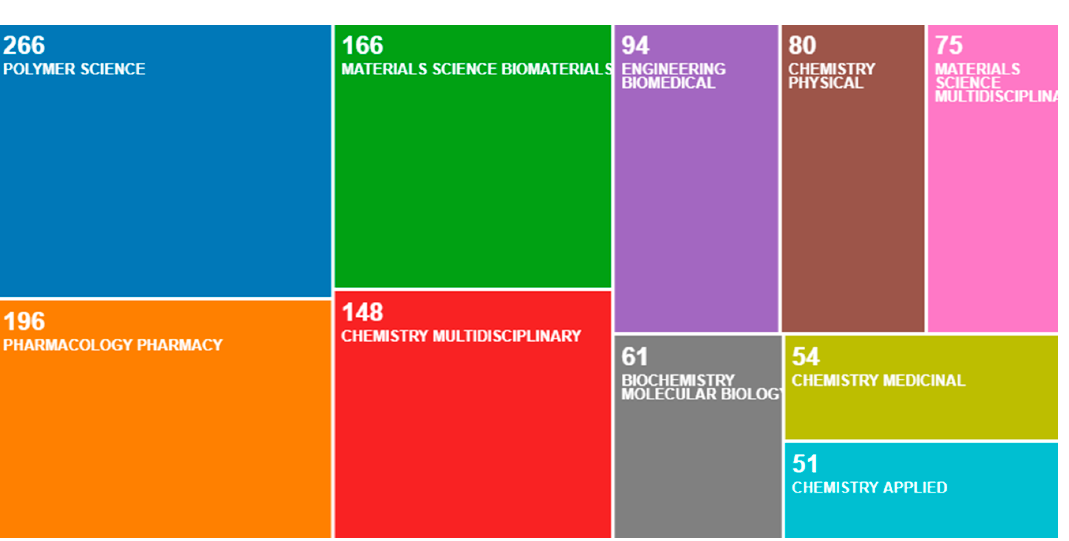
Figure 3. Tree map shows the number of articles published under different research areas in the last five years. The keywords used for the search and analysis were ‘PolyHy’ and ‘Drug Releasing Systems’. WoS source, August 2020.